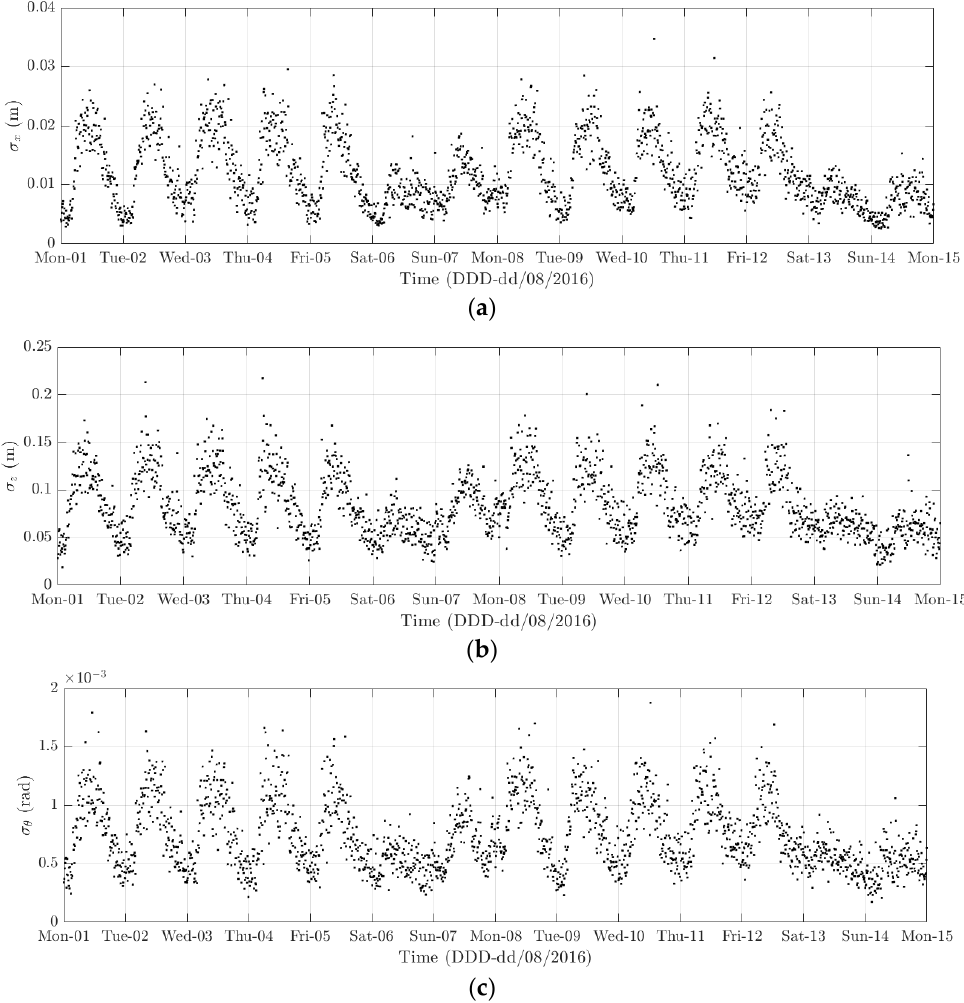
Figure 20. Variation of the 10 ‐ min standard deviation of ( a ) the longitudinal deformation; ( b ) heaving deformation; and, ( c ) torsional deformation from 1 to 14 August 2016.